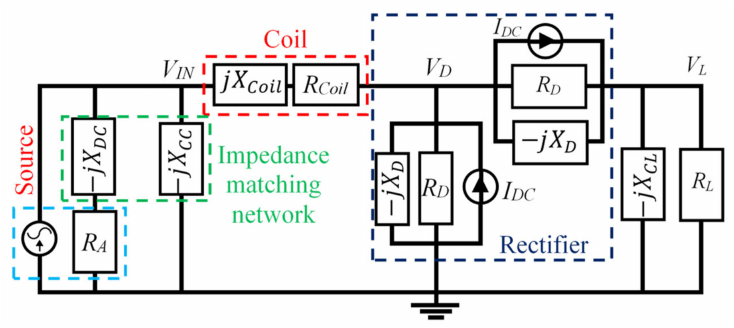
Figure 3. A linearized model of the RF power harvester.